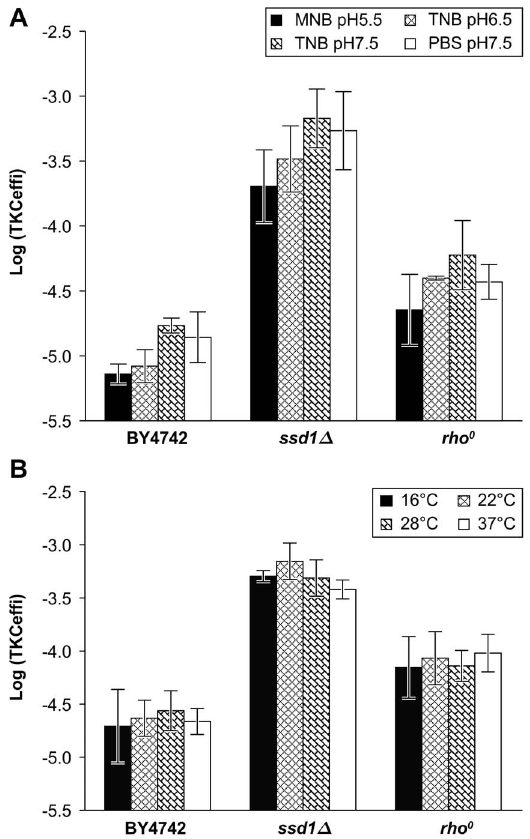
Figure 3. Universality of high receptivity under various reaction conditions in high receptivity mutants. TKC efficiency was examined using SSD1 deletion mutant ( ssd1 D ), and rho 0 mutant in various reaction buffers (A) or under various temparature (B). Data are represented as mean 6 SD (n=3). In all reaction conditions examined, the high recepitivity mutants showed higher recepitivity comparing with parental strain, and they were statistically significant at p , 0.05 except rho 0 mutant at 16 u C (two-tailed t -test). HB101 (pRH210, pAY205) was used as the donor.